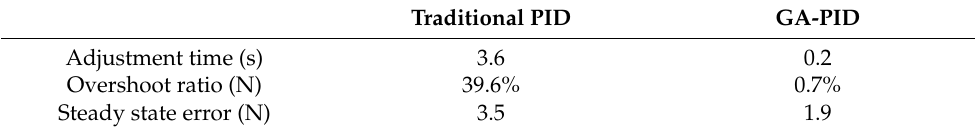
Figure 10. Propulsion control under coal hardness of sudden change. Table 6. Simulation data of propulsive force under coal hardness of sudden change.